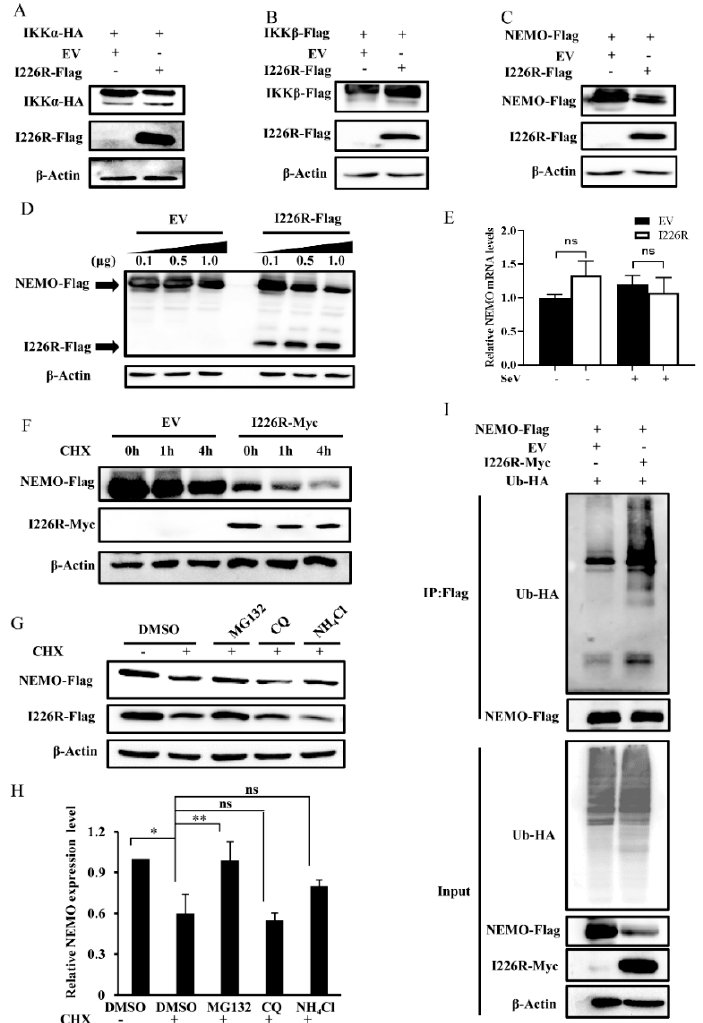
Figure 7. The I226R protein promotes the degradation of NEMO through enhancing its ubiquitination: ( A – C ) 293T cells were co-transfected with 1 µ g I226R-Flag or EV and 1 µ g IKK α -HA ( A ), IKK β -Flag ( B ), or NEMO-Flag plasmids ( C ). Western blotting was then performed. ( D ) 1 µ g NEMO-Flag was co- transfected with varying amounts of I226R-Flag plasmid in 293T cells. Western blotting was then performed. ( E ) 293T cells were transfected with 3 µ g I226R-Flag or EV and infected with SeV for 12 h. RT − qPCR was performed to detect the mRNA levels of NEMO. ( F ) 1 μ g NEMO − Flag was co − transfected with 1 μ g I226R − Myc or EV and subjected to 50 μ g /mL CHX treatment for indicated hours. Then, Western blotting was performed. ( G , H ) 293T cells were co − transfected with 1 μ g I226R and 1 μ g NEMO and treated with 50 μ g/mL CHX and either 20 mM MG132, 50 mM CQ, 20 mM NH 4 Cl, or DMSO. Western blotting was performed to evaluate the expression of NEMO. Relative levels of NEMO were quantitated by densitometry and normalized to β− actin levels (H). ( I ) 293T cells were trans- fected with 1.5 μ g I226R − Myc or EV, along with 1 μ g NEMO − Flag and 1.5 μ g Ub − HA. At 24 h after transfection, IP and Western blotting were performed to evaluate the ubiquitination lev- els of NEMO. Statistical analysis was performed using the Student’s t -test. * p < 0.05; ** p < 0.01. Since I226R affects the expression of NEMO at the protein level, we asked whether I226R could regulate the expression of NEMO at the mRNA level. As shown in Figure 7E, no significant difference in the expression of NEMO at the mRNA level was observed between I226R-overexpressing and control cells. We next examined the protein stability of NEMO after treatment with CHX, an inhibitor of protein synthesis, in I226R-